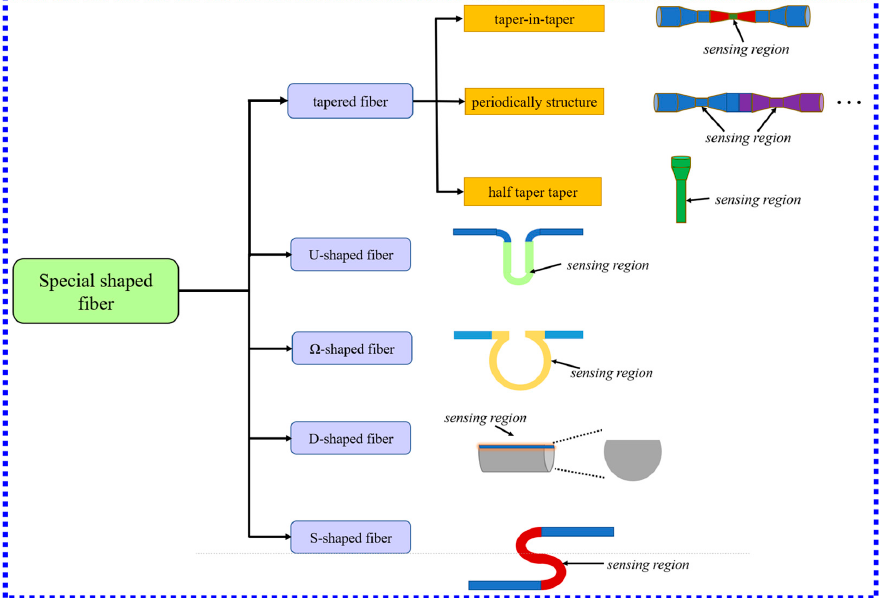
Figure 8. Schematic diagram of the classification and typical structure of LSPR biosensors with special shapes.